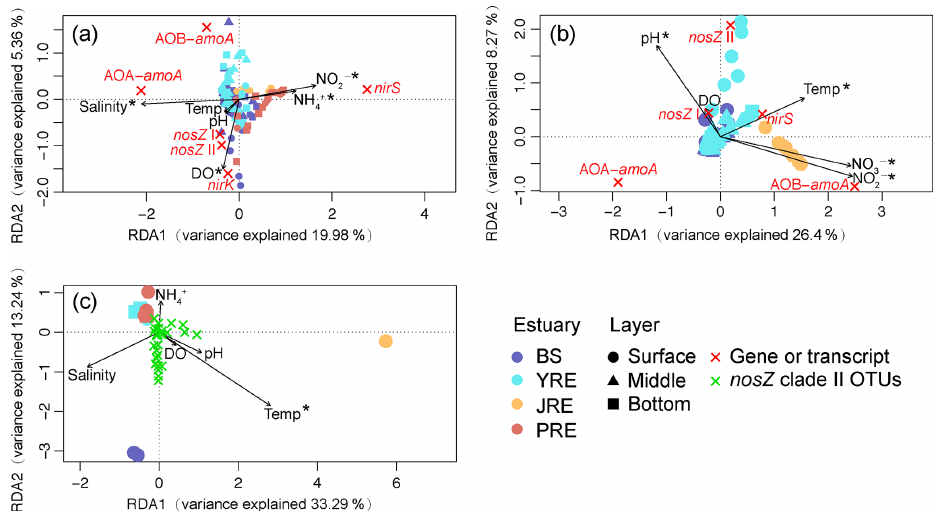
Figure 5. Redundancy analysis of the relative abundances of ammonia-oxidizing archaeal amoA (AOA- amoA ), bacterial amoA (AOB- amoA ), nirS , nirK , and nosZ clade I and II (a) genes and (b) transcripts, as well as of (c) the community composition of the nosZ clade II clone libraries under biogeochemical constraints. Each circle, triangle, or square represents an individual sample from the surface, middle, or bottom layer, respectively. The fork-shaped symbol represents the functional gene, transcript, or nosZ clade II OTU. Vectors represent environmental variables. Asterisks indicate statistically significant variables. Temp, temperature; DO, dissolved